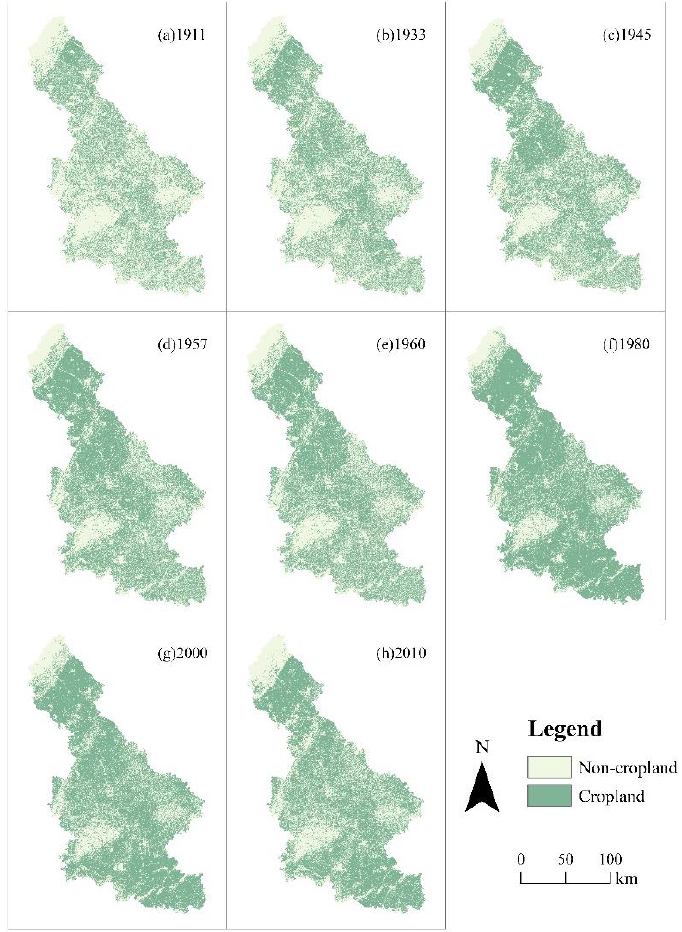
Figure 5. Spatial distributions of 30 m × 30 m cropland grids in the Tuojiang River Basin from 1911–2010 ( a – h 1911 – 2010.